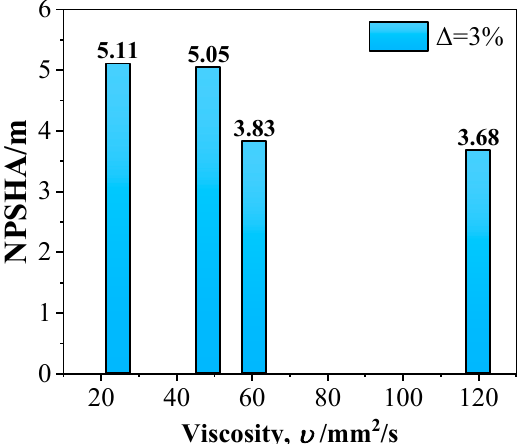
Figure 7. NPSHA under different fluid viscosity ( Q d = 100 m 3 /h, n = 4500 rpm).